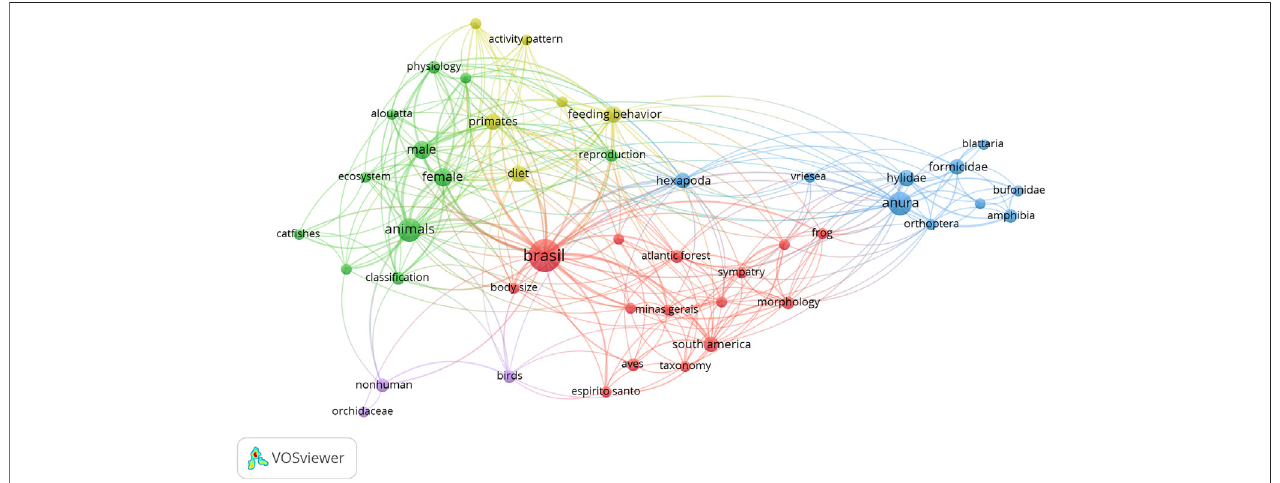
FIGURE 2 | Co-occurrence between the analyzed institutional production terms (1993 – 2019).